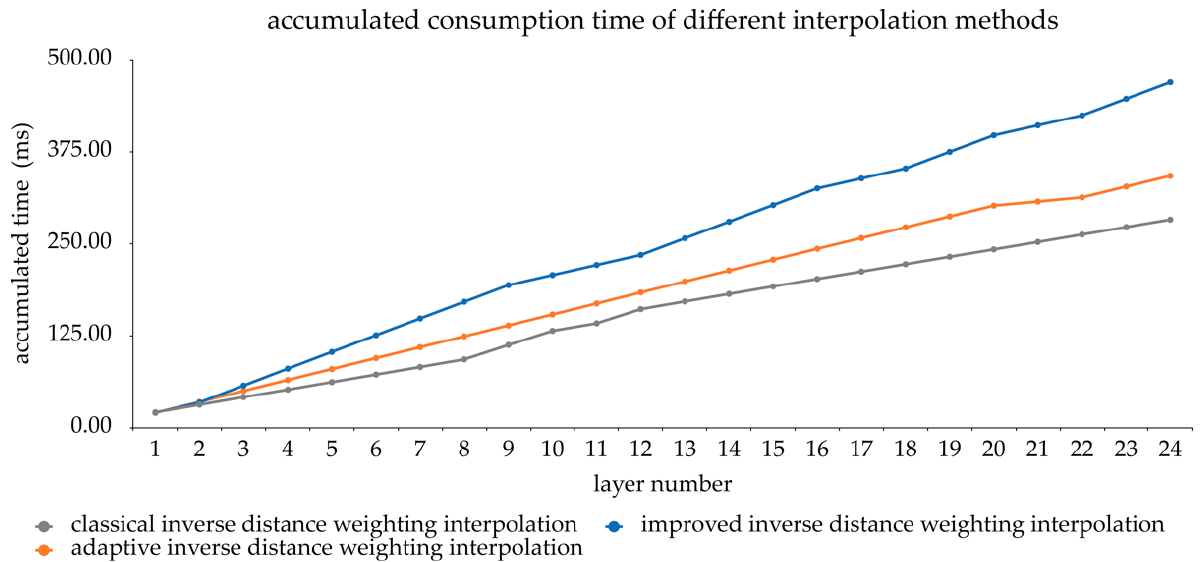
Figure 11. Accumulated time consumption of different interpolation methods.